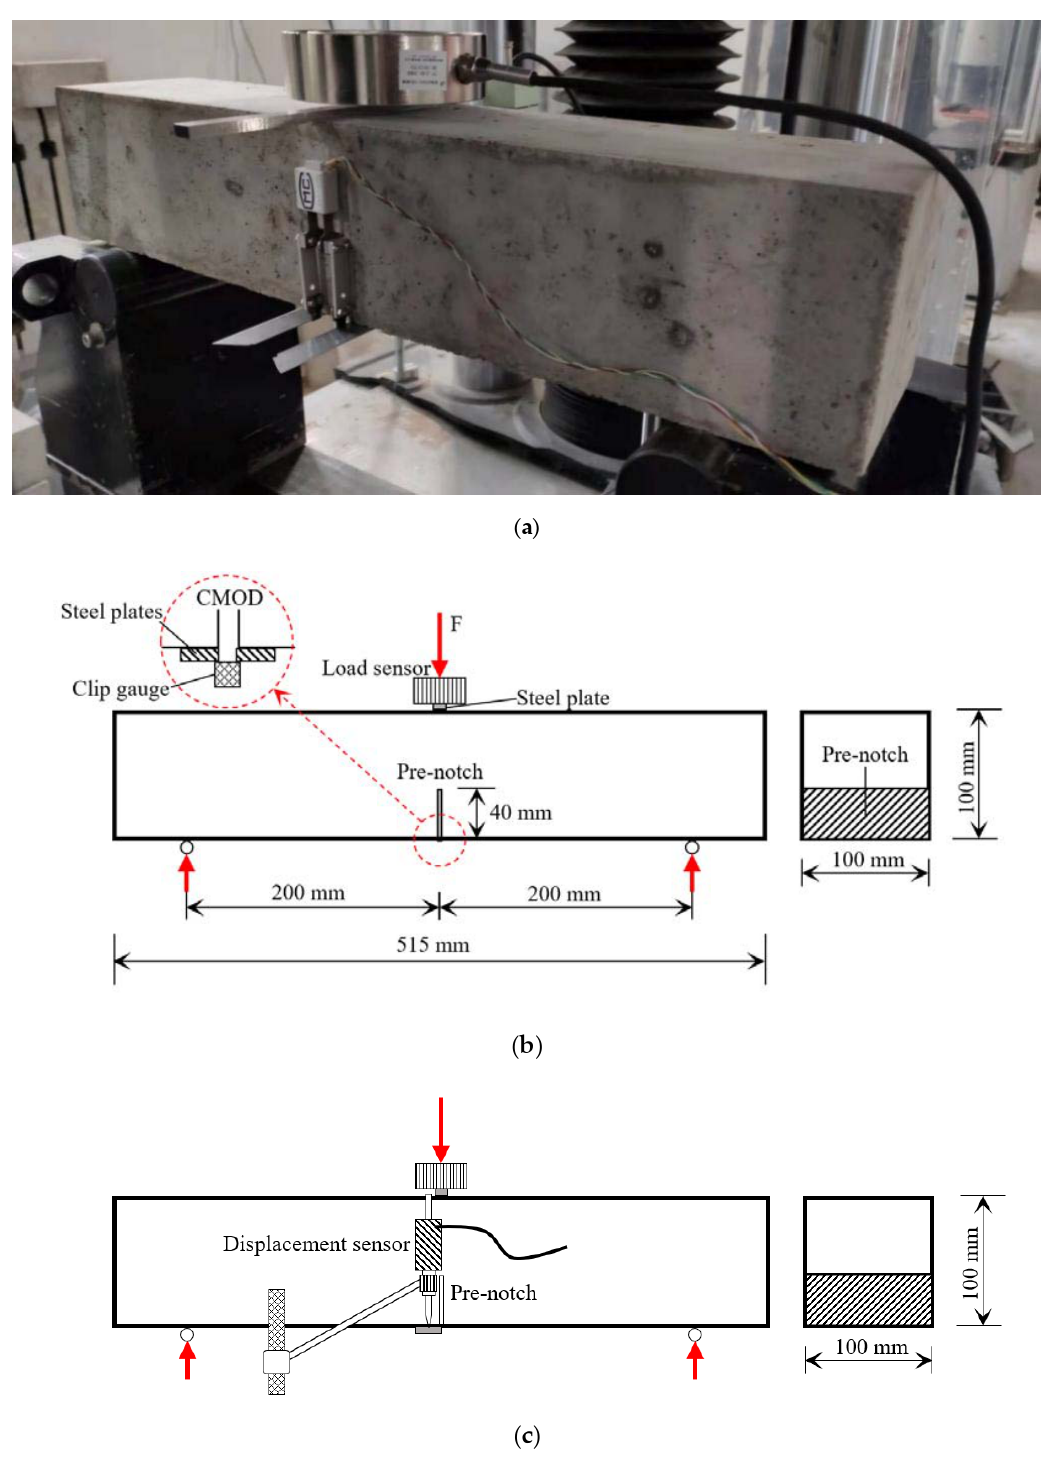
Figure 3. Schematic diagram of three ‐ point bending fracture test: ( a ) experimental setup; ( b ) schematic of front view; ( c ) schematic of rear view.